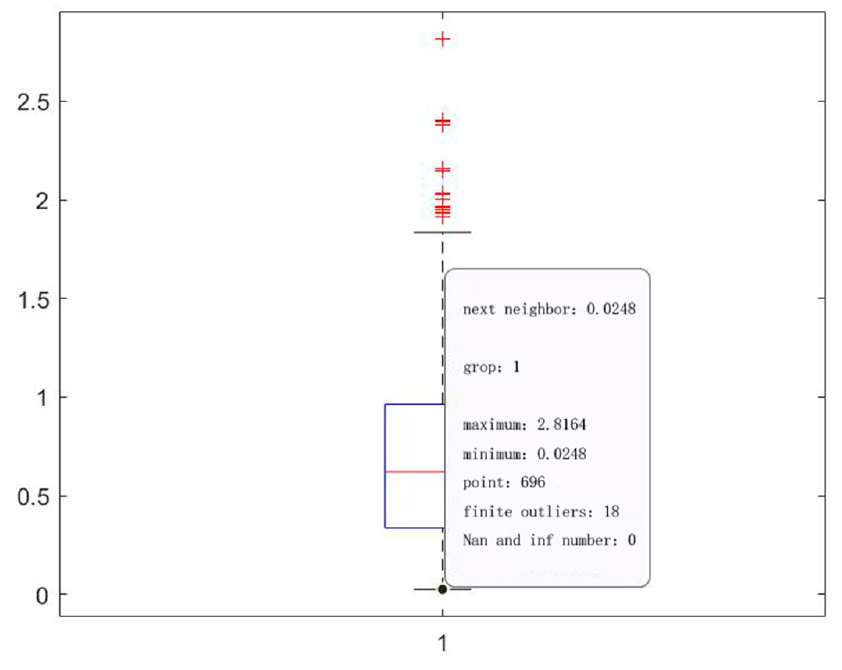
Figure 4. Quartile detection on various KPI data.